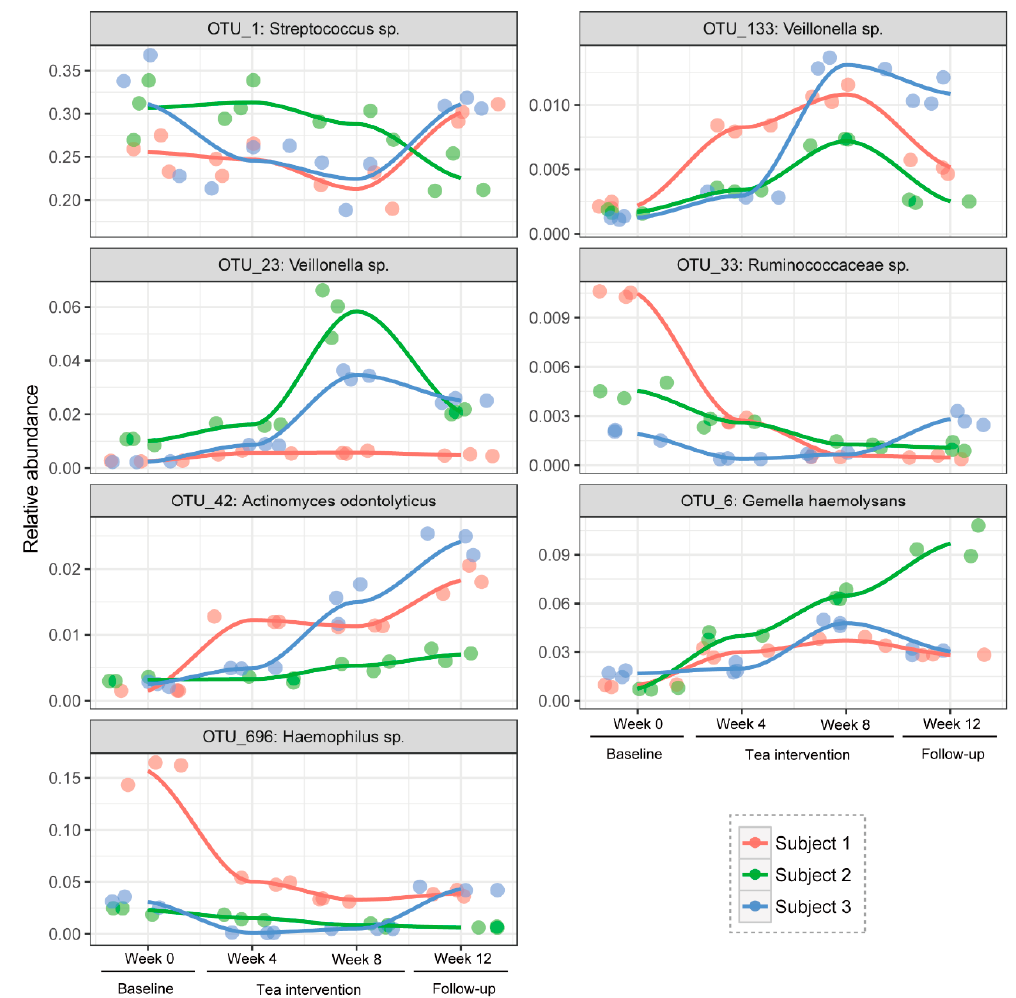
Figure 5. The temporal shifts of the shared hub salivary microbiota during the 12-week experimental